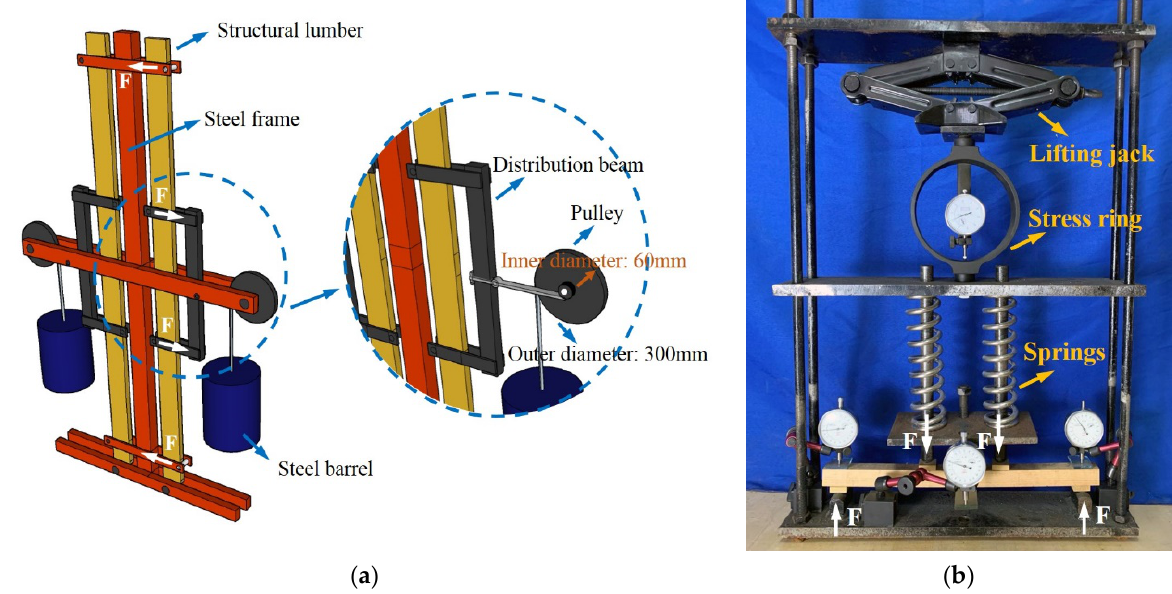
Figure 2. Long-term bending test of dimension lumber and the clear wood. ( a ) Dimension lumber, ( b ) Small clear specimen.